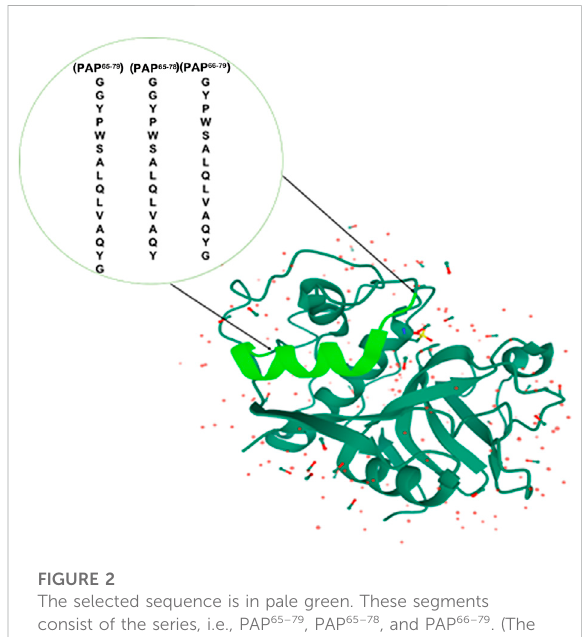
FIGURE 2 The selected sequence is in pale green. These segments consist of the series, i.e., PAP 65 – 79 , PAP 65 – 78 , and PAP 66 – 79 . (The crystal structure of PAP was reproduced from https://www.rcsb. org/3d-view/9PAP, and PDB ID: